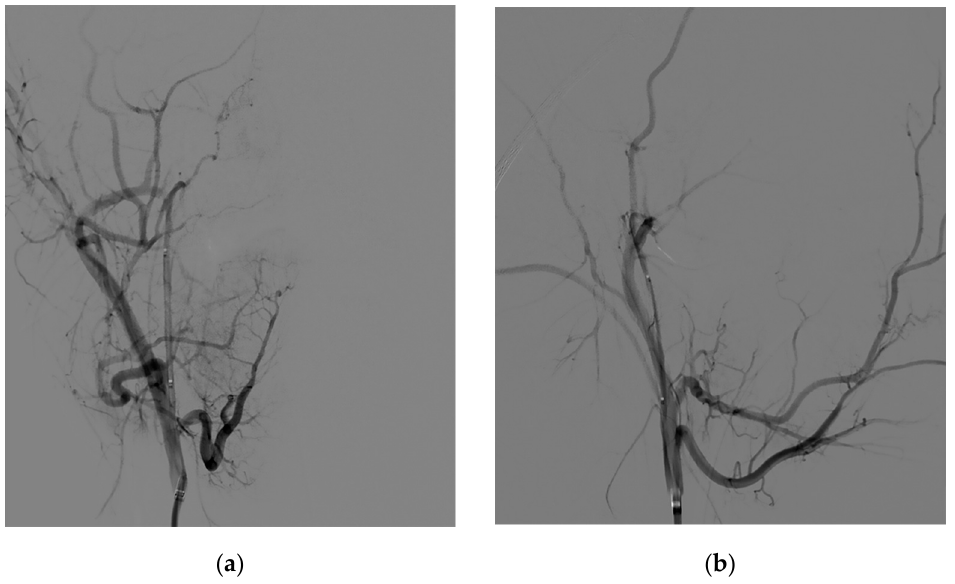
Figure 4. Postprocedural DSA: PA ( a ) and LL ( b ) views of the JNA showing successful embolization of the lesion.